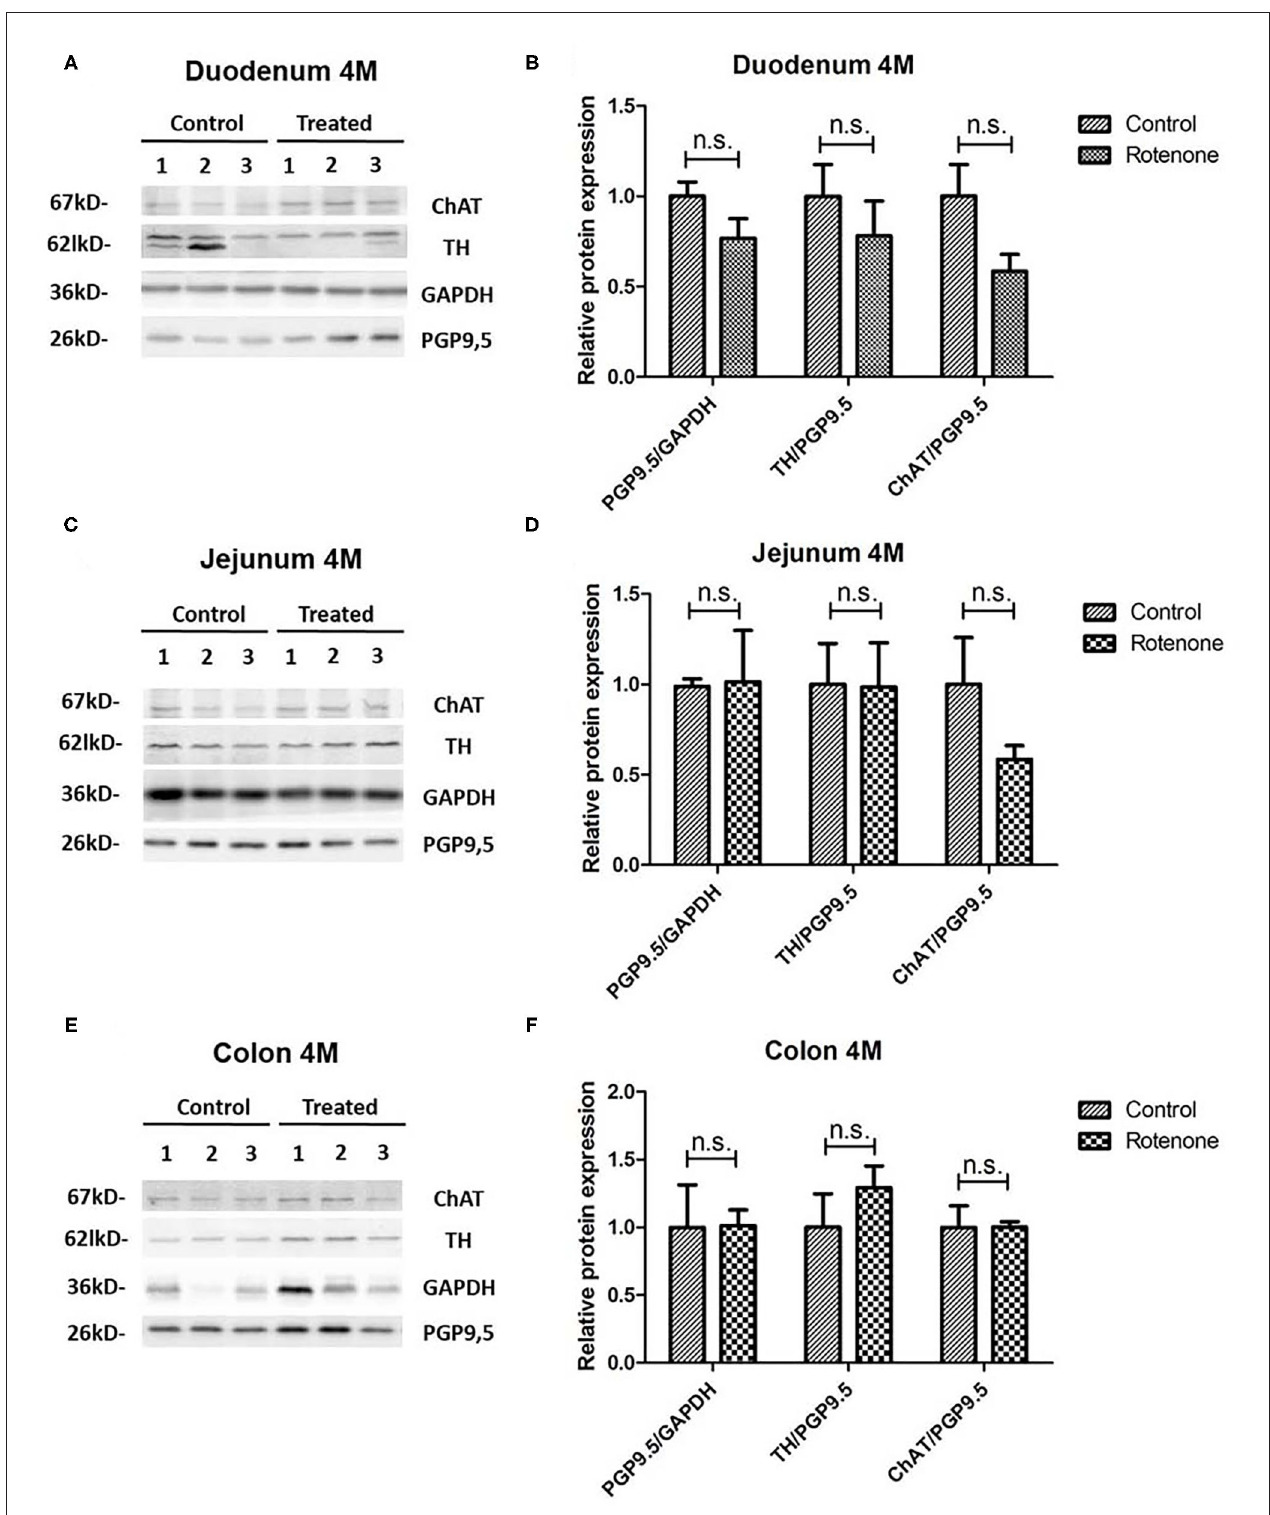
FIGURE 13 | Effect of 4-month rotenone on the expression of ChAT, TH, and PGP9.5 in each intestinal region. Western blots in (A,C,E) show three representative examples per exposure group for the protein levels of ChAT, TH, GAPDH, and PGP9.5 in duodenum (A) , jejunum (C) , and colon (E) . The protein gene product